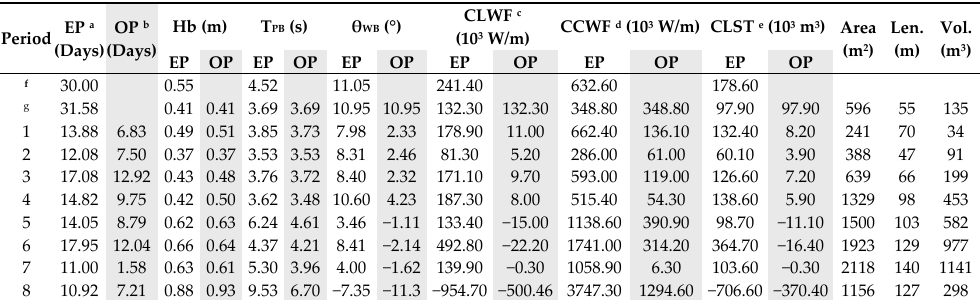
Table 1. Duration (time elapsed between measurements), wave conditions (T PB and θ WB are weighted averages, as a function of Hb), longshore and cross-shore components of wave flux, and cumulative sediment transport (using CERC formula).